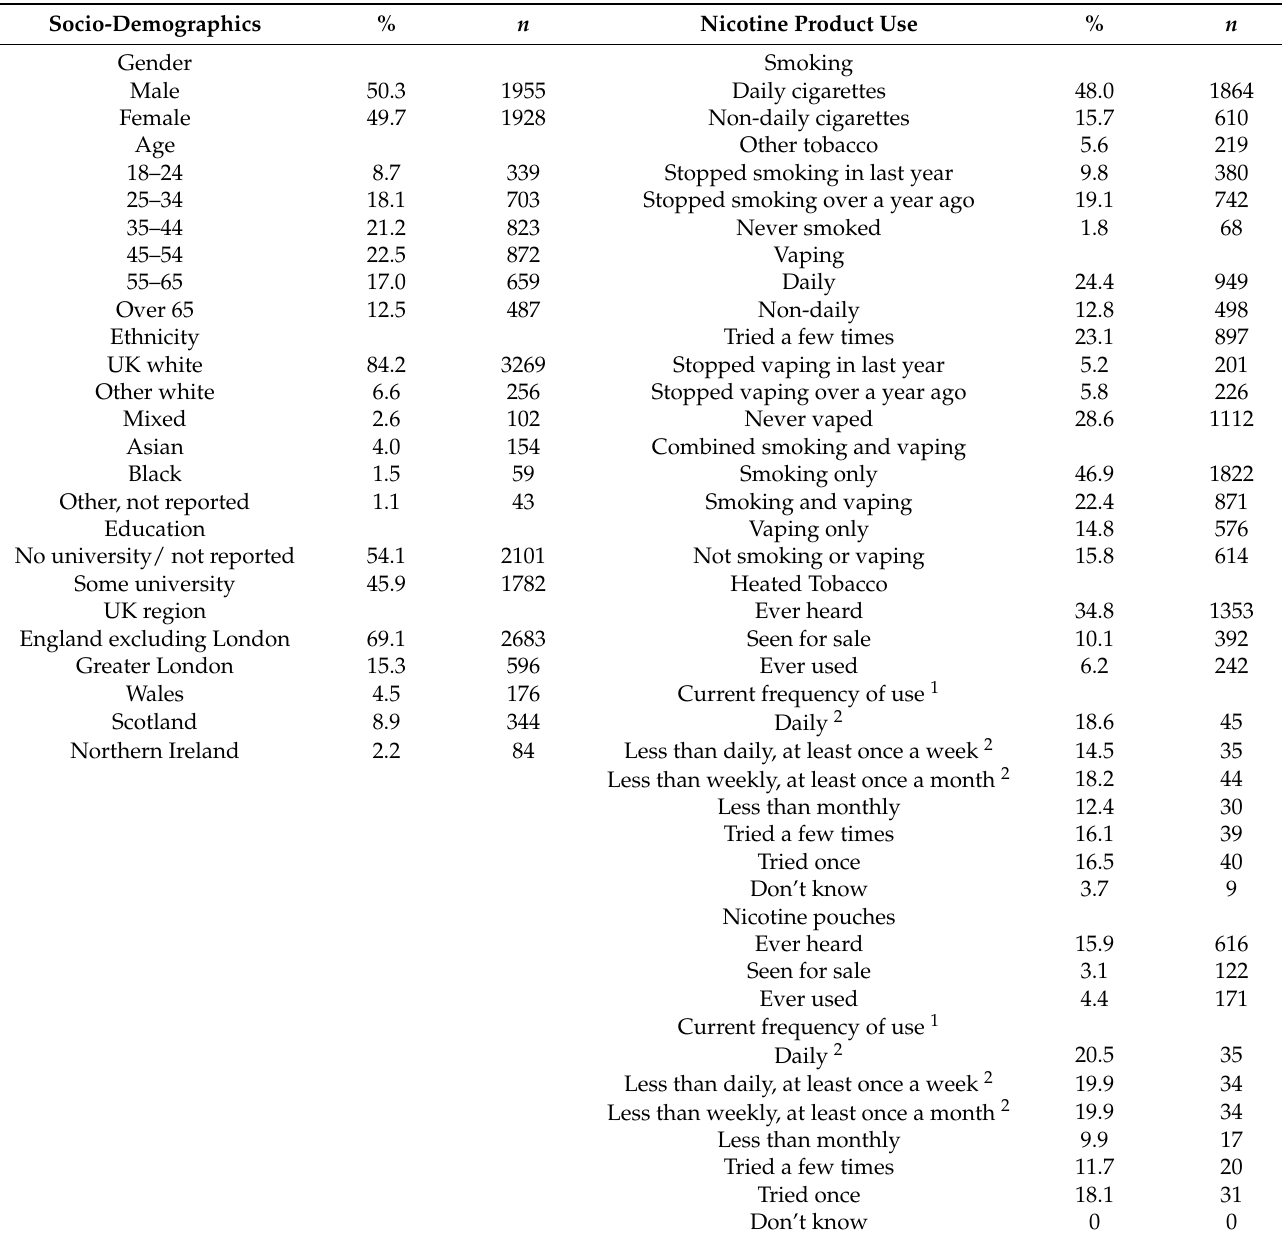
Table 1. Sample description, n =